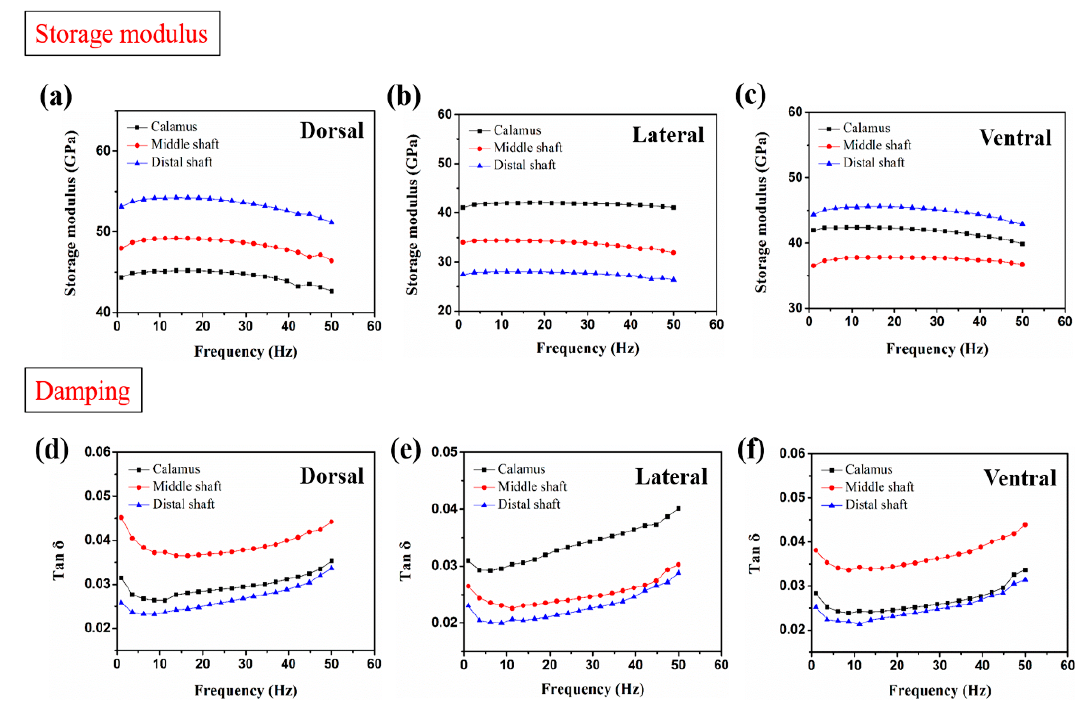
Figure 5. Plots of the storage modulus and damping of the ( a , d ) dorsal, ( b,e ) lateral and ( c , f ) ventral cortex, respectively.